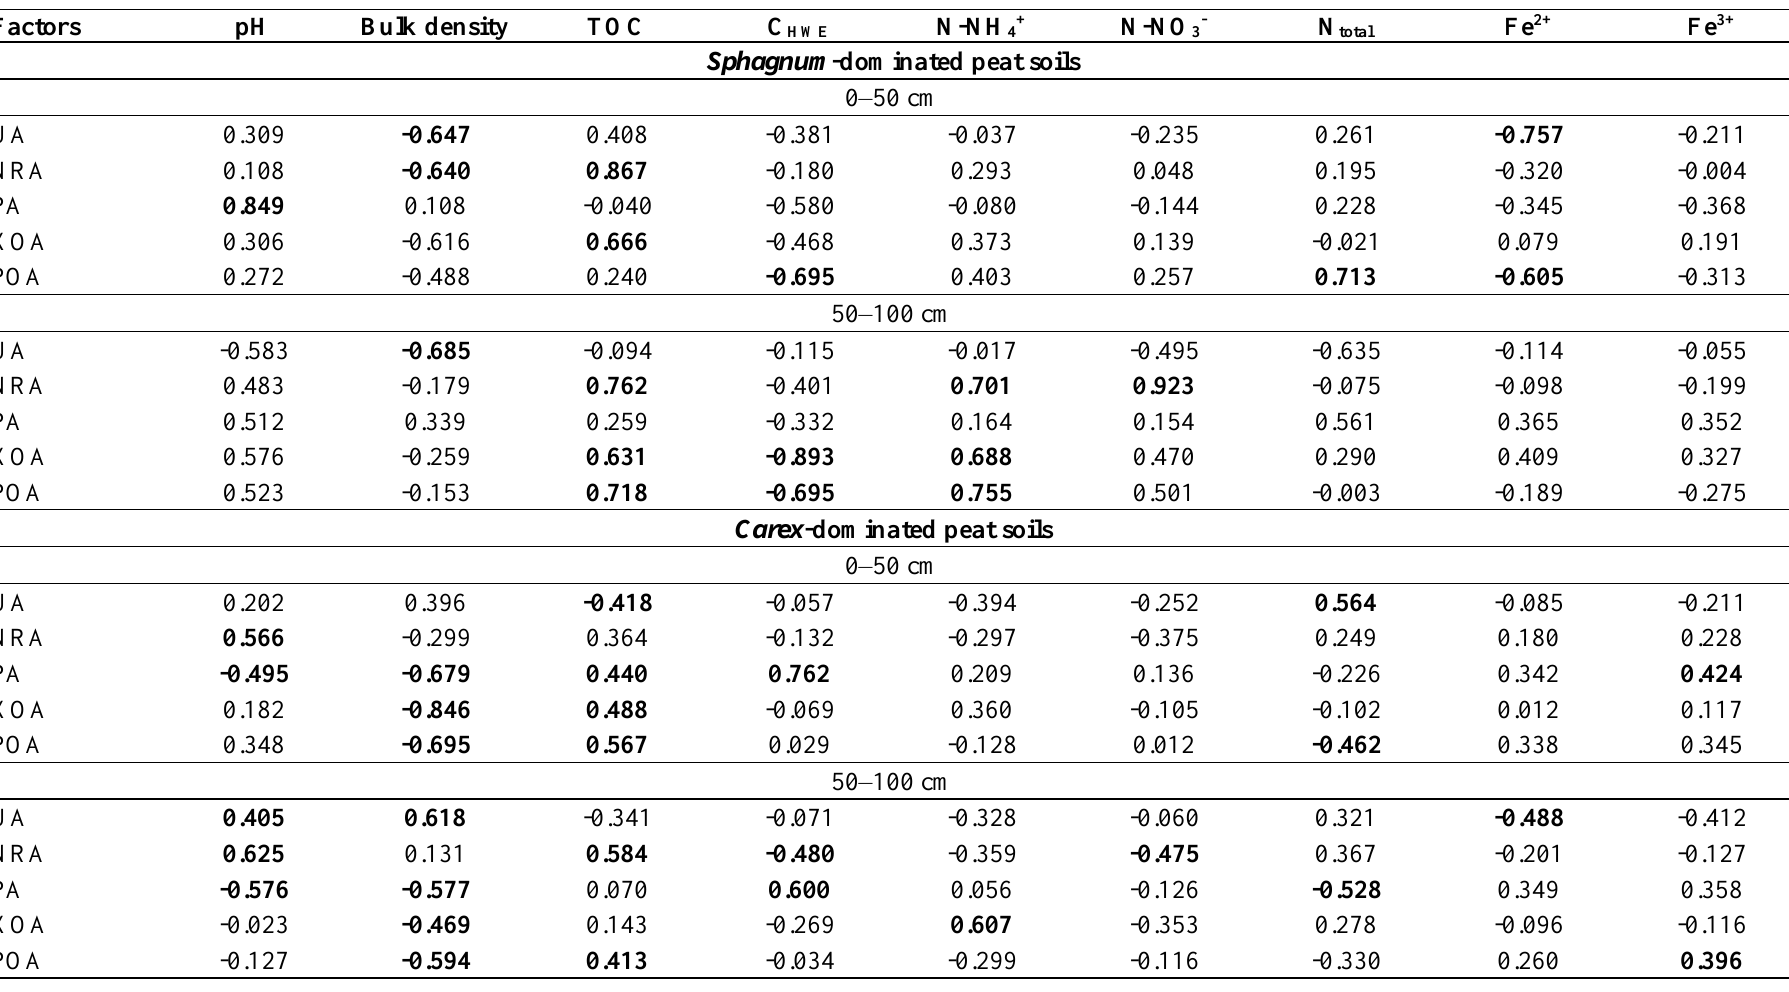
Table 3. Correlation coefficients in 0–50 cm and 50–100 cm soil layers. Significant correlation coefficients (significance level p < 0.05, see Table 2) are shown in bold